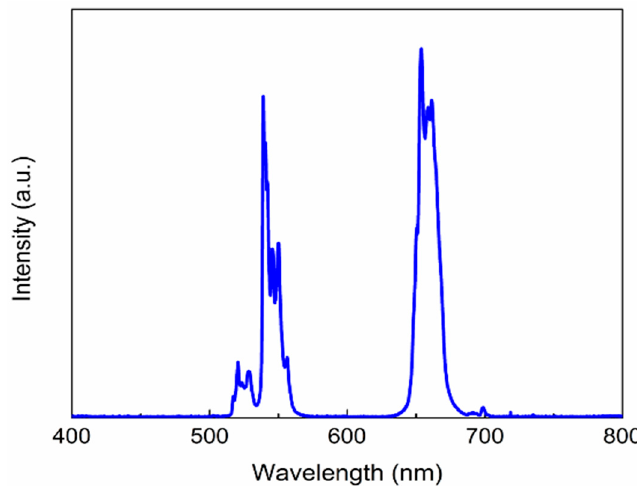
Figure 2. The emission spectrum of core-shell ( β -NaYF 4 : 20%Yb 3+ , 2%Er 3+ @NaYF 4 ) upconversion nanoparticles showing their peak positions obtained by exciting the nanoparticles with 980 nm CW laser (375 mW cm − 2 , 100 ms).